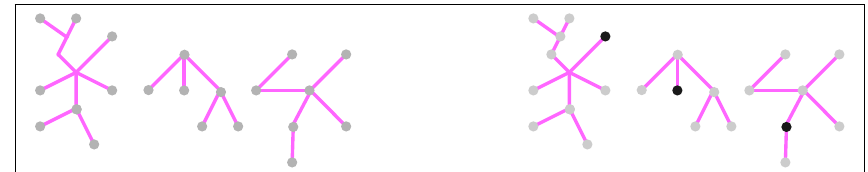
Figure 2: A forest (left) and a 3 –rooted forest